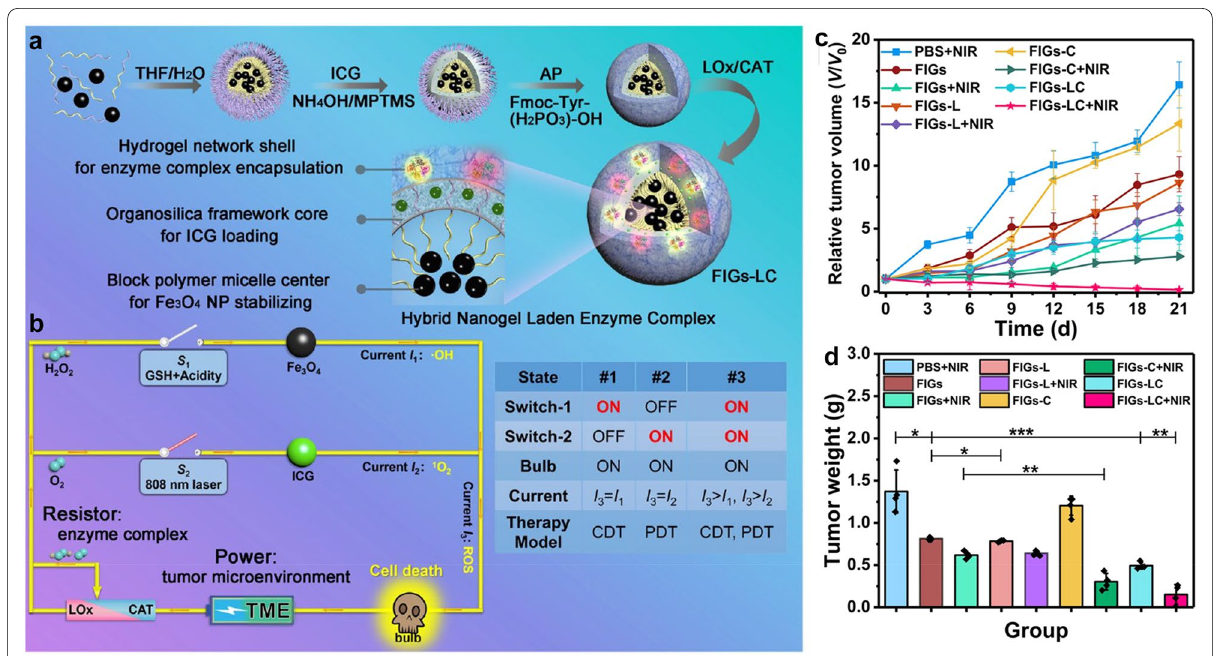
Fig. 6 a The synthetic procedures of hybrid enzyme nanogel (FIGs-LC) include: (1) self-assembly of Fe 3 O 4 nanoparticles-encapsulated polystyrene- block -poly (acrylic acid) (PS- b -PAA) micelles (Fe 3 O 4 @PS- b -PAA) in selective solution; (2) the formation of ICG-loaded hybrid nanoparticles (Fe 3 O 4 @IHPs) by doping ICG and introducing organic silane 3-mercaptopropyltrimethoxysilane (MPTMS); (3) acid phosphatase (AP)-triggered hydrogel coating onto Fe 3 O 4 @IHPs, denoted with Fe 3 O 4 @IHPs nanogels (FIGs); (4) immobilization of LOx and CAT into FIGs, the final particles are denoted by FIGs-LC. b Schematic circuit diagram for the peroxisome-inspired therapeutic mechanism of FIGs-LC based on the dual-enzyme-regulated ROS generation with GSH and NIR activation: the intratumoral lactate and H 2 O 2 are catalyzed by LOx and CAT (resistor regulation) to generate